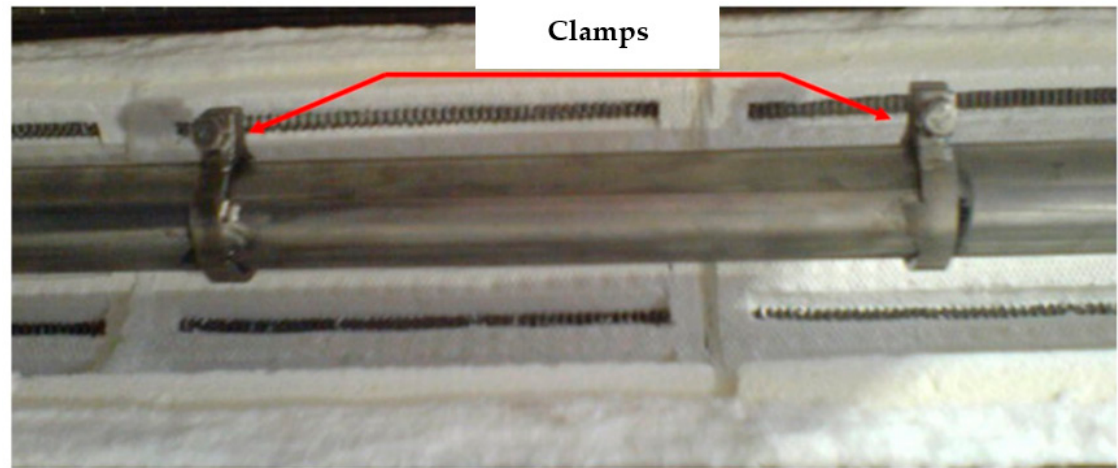
Figure 7. The clamps securing the reactor against opening during the gasification process.